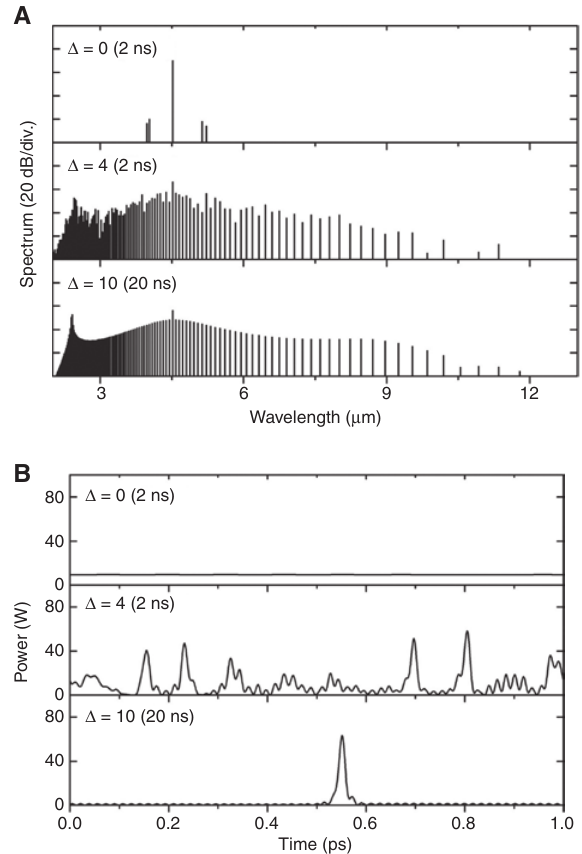
Figure 4: Comb generation in (A) frequency and (B) time domains at the normalized pump detuning Δ = 0, 4, and 10.